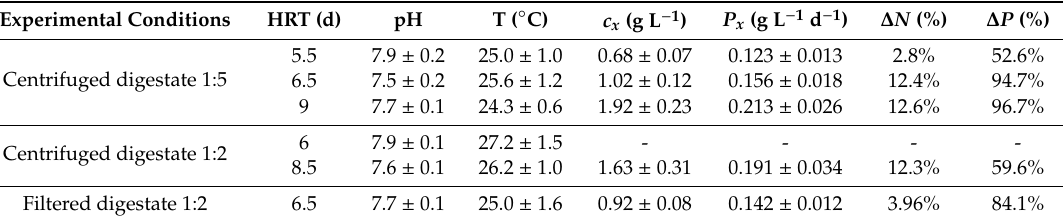
Table 2. Steady-state results of continuous lab-scale